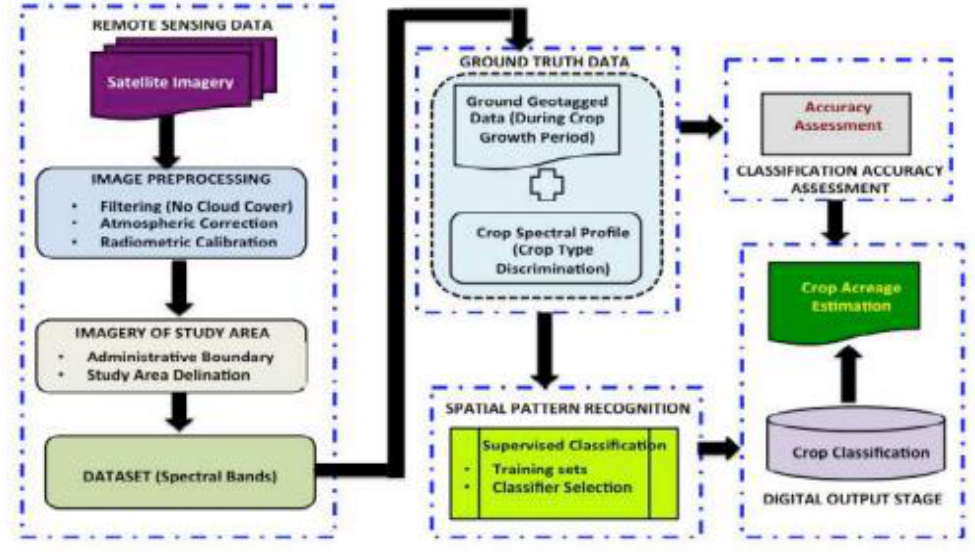
Figure 2. Flowchart depicting traditional method of crop acreage estimation using remote sensing satellite imagery.